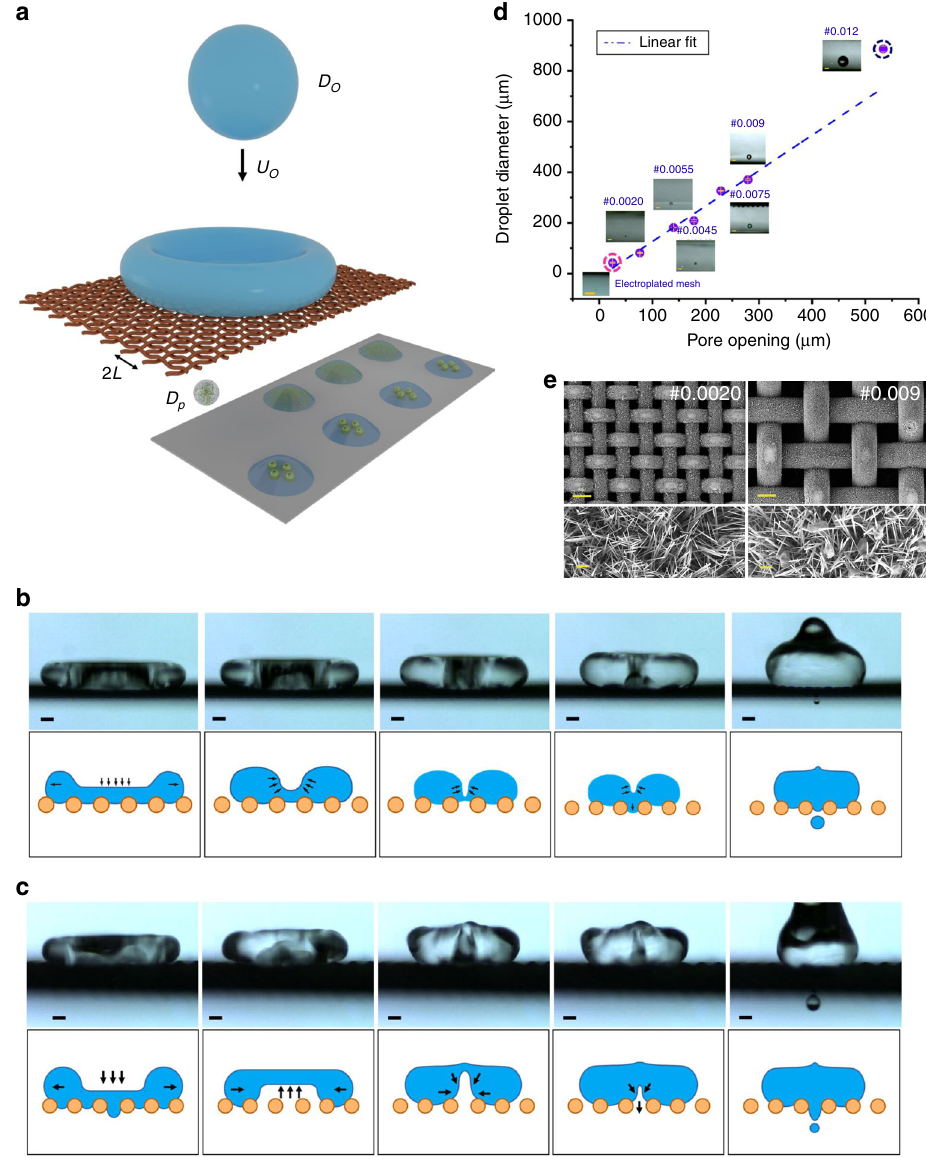
Fig. 1 Mechanism and explanation of drop-impact printing technique. a Schematic illustration showing the drop-impact setup, a droplet (diameter D o , velocity U o ) impacting on a superhydrophobic sieve (pore opening, L ) to eject out a single smaller droplet (diameter D p ). The impacting drop gives rise to two modes of single-droplet ejection. b Impact cavity (IC) and ( c ) recoil cavity (RC). Scale bar: 200 µ m. The time-lapsed images and schematic illustration for IC and RC modes show the mechanism of cavity formation and collapse using sieve #0.0045 with 65% glycerol water droplet and sieve #0.009 with pure water droplet, respectively. The drop-impact printing technique was explored in terms of the smallest ejected droplet that can be generated. d Shows a plot between water droplet diameter versus pore opening, and the insets show the corresponding patterned droplet (scale bar: 100 µ m). Superhydrophobic sieves with different pore openings were used starting from sieve type #0.012 (pore opening L: 533.4 µ m, wire diameter W: 304.8 µ m) to #0.0020 (pore opening L: 76.2 µ m, wire diameter W: 50.8 µ m) and electroplated mesh (pore opening L: 25.2 µ m, wire diameter W: 101.2 µ m) marked in blue-dotted circle. e Scanning electron microscopy (SEM) images of sieves #0.009 and #0.0020 (scale bar: 100 µ m, magni fi ed image scale bar: 2 µ